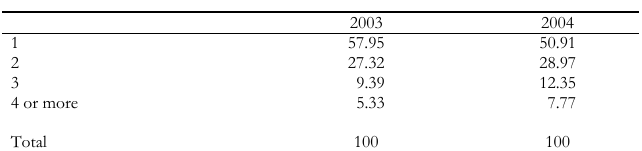
TABLE 2 Number of long holidays taken by respondents (percentage among individuals that declared at least one long